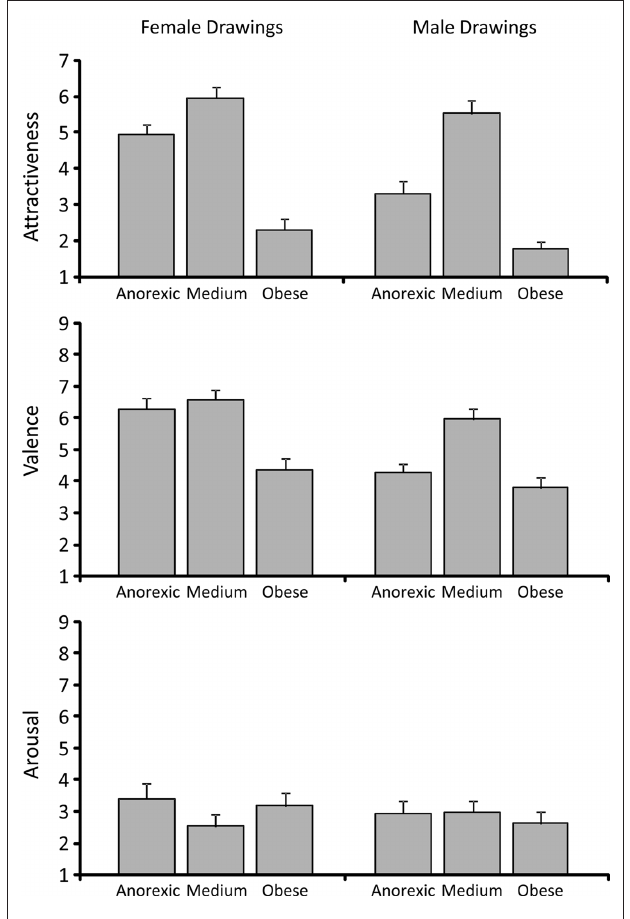
FiguRE 3 | Mean ratings of attractiveness, valence, and arousal of the body drawings, separately for female and male body drawings (left and right